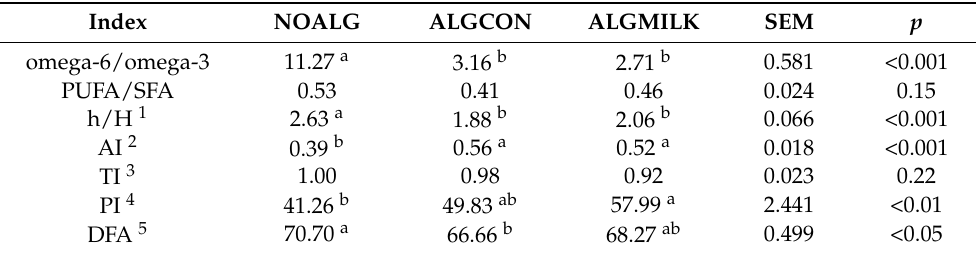
Table 5. Lipid quality indices in intramuscular fat of feedlot lambs fed a conventional diet alone (NOALG) or feedlot lambs with competent reticular groove reflex fed the same diet supplemented with 2.5% of algae meal, either mixed in the concentrate (ALGCON) or in the milk replacer